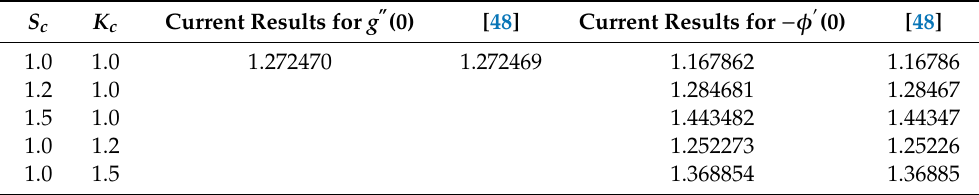
Figure 16. Sherwood number with the variation of β 1 . Table 1. Comparability for the current outcomes of g (cid:48)(cid:48) ( 0 ) and − φ (cid:48) ( 0 ) , along with the preceding